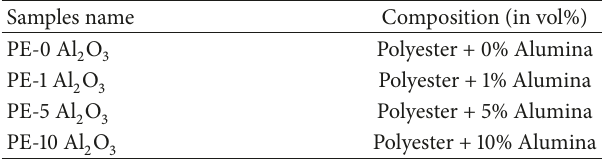
Table 2: Designation and composition of the prepared